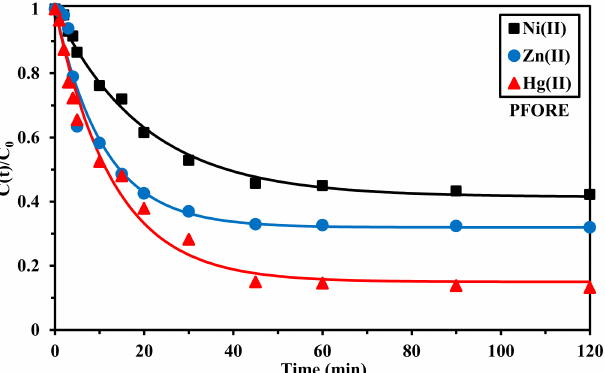
Figure 5. Uptake kinetics for Ni(II), Zn(II) and Hg(II) using G@MChs for single-component solutions— modeling with the PFORE (C 0 : 0.3 mmol L − 1 ; pH 0 : 5.5; pH eq : 5.75 (Ni), 5.80 (Zn), and 6.01 (Hg); Sorbent dose, SD: 1 g L − 1 ; T: 21 ± 1 ◦ C; time: 300 min (equilibrium reached before 120 min); agitation speed: 150